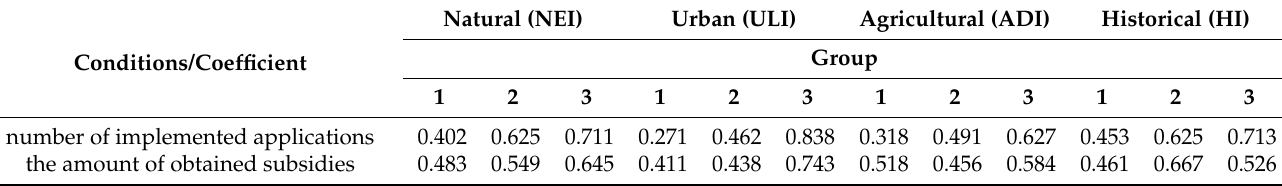
Table 2. Dependencies between the selected conditions and the level of use of RDP funds. Natural (NEI) Urban (ULI) Agricultural (ADI) Historical (HI) Group Conditions/Coefficient 1 2